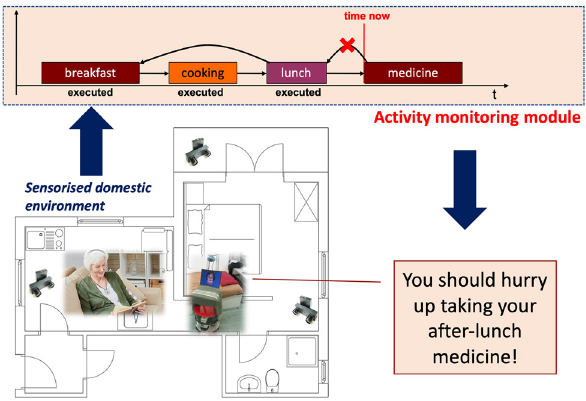
Figure 2: The R OBO C ARE Domestic Environment: AI - based technology reasons on monitored activities and issues warnings and alarms through a robotic